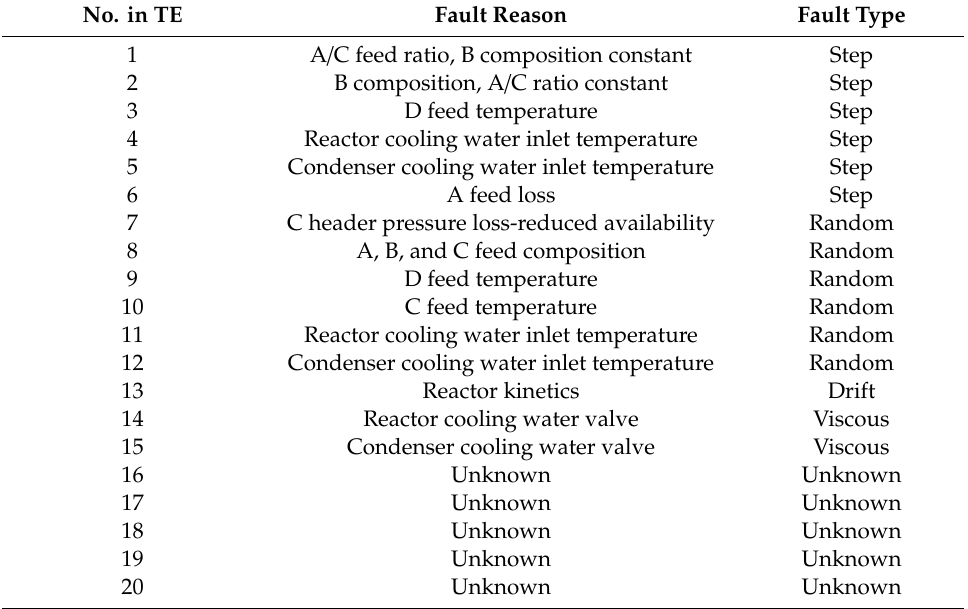
Table 3. Preset faults of the TE process.